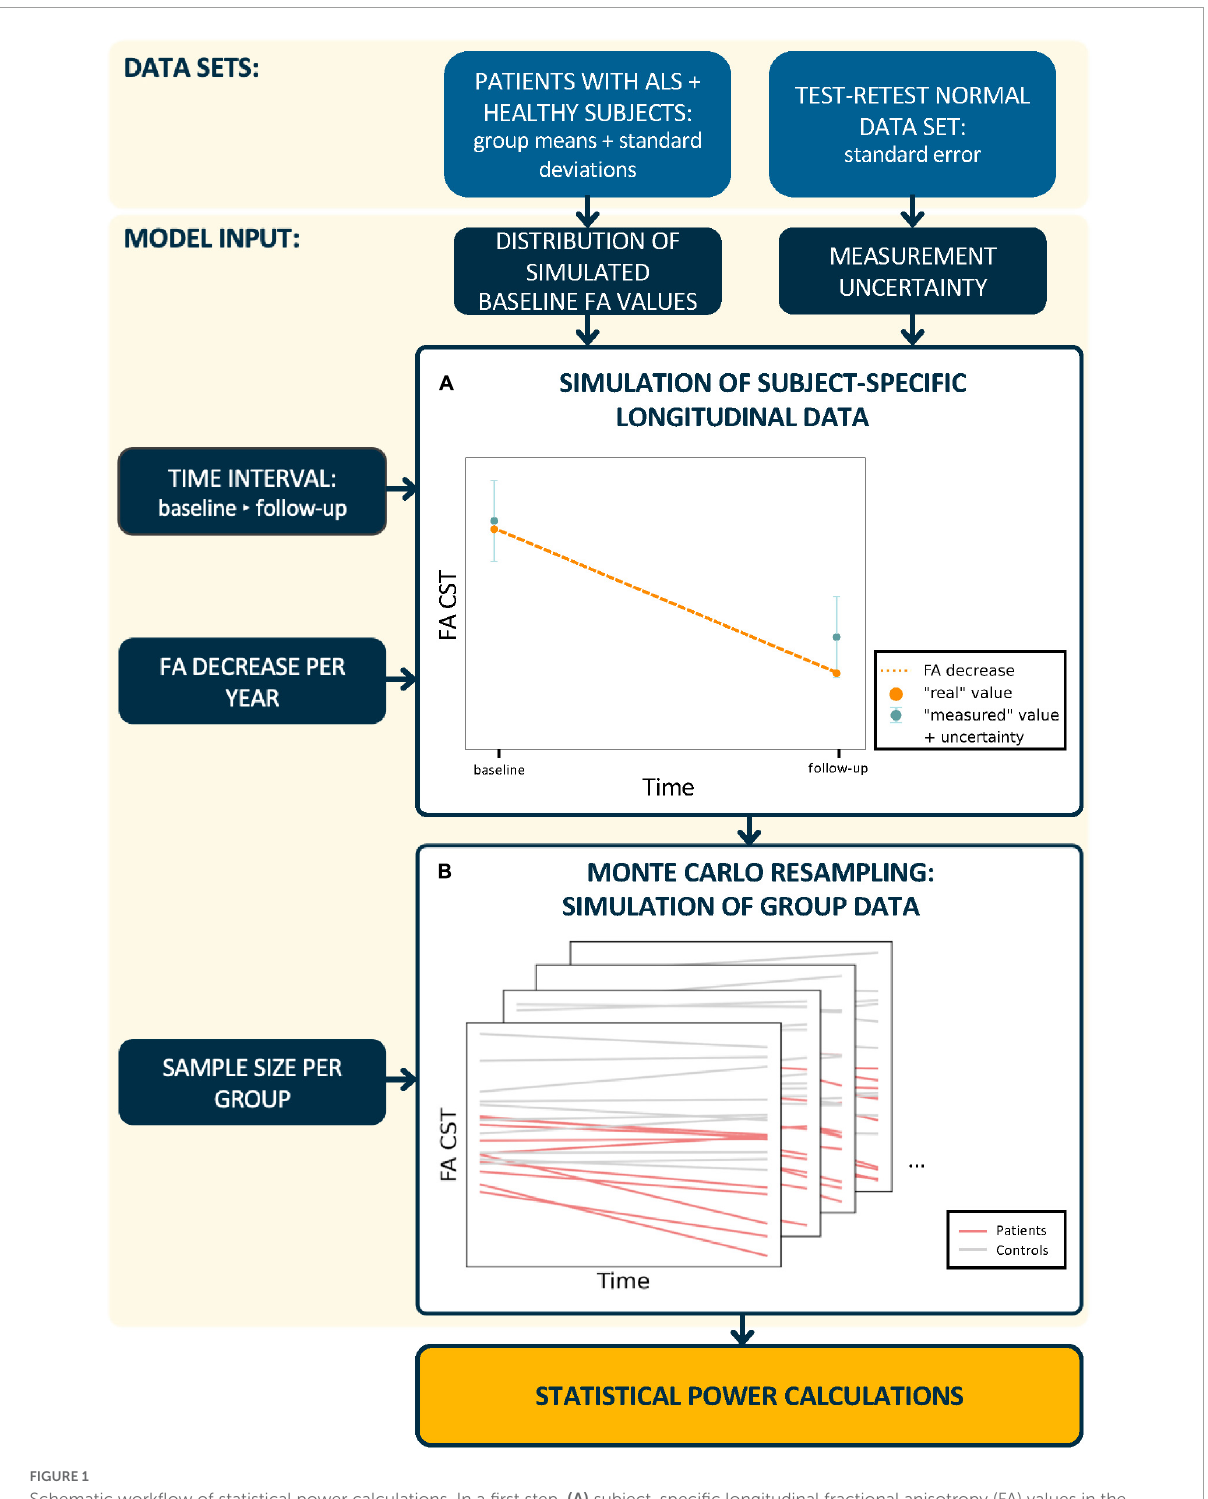
FIGURE1 Schematic workflow of statistical power calculations. In a first step, (A) subject-specific longitudinal fractional anisotropy (FA) values in the corticospinal tract (CST) were simulated. Therefore, synthetic baseline values for patients and healthy controls were generated from real subject data distributions. The calculation of synthetic “measured” follow-up FA values incorporated a predefined FA decrease and measurement uncertainty. In a second step, (B) longitudinal trajectories were generated for n subjects per group and the statistical power was calculated from 2,000 Monte Carlo resampled data sets. This procedure was performed for different time intervals between baseline and follow-up sessions, measurement uncertainties, longitudinal FA decrease rates, and sample